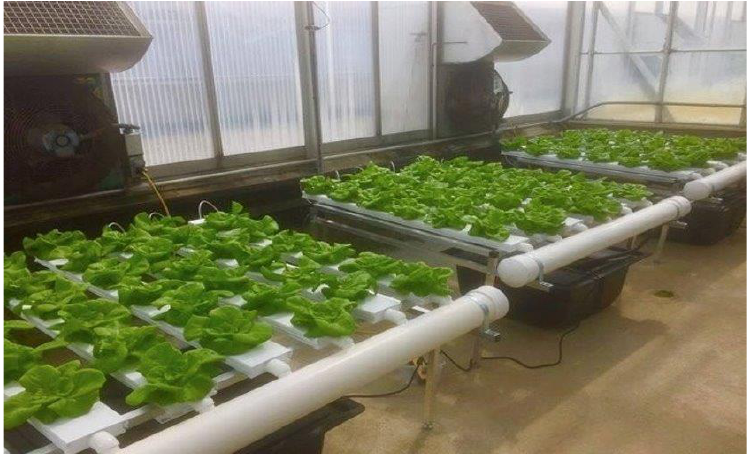
Figure 1. Nutrient Film Technology (NFT) system units with four channels containing six plant spaces (NFT 4–6) fitted with 25-gal (95 lit) reservoir and the pump for re-circulating nutrient solution (CropKing Inc., Lodi, OH, USA) set up in Biosafety Level 2 (BSL-2) greenhouse space at the Ohio State University (Wooster, OH, USA).